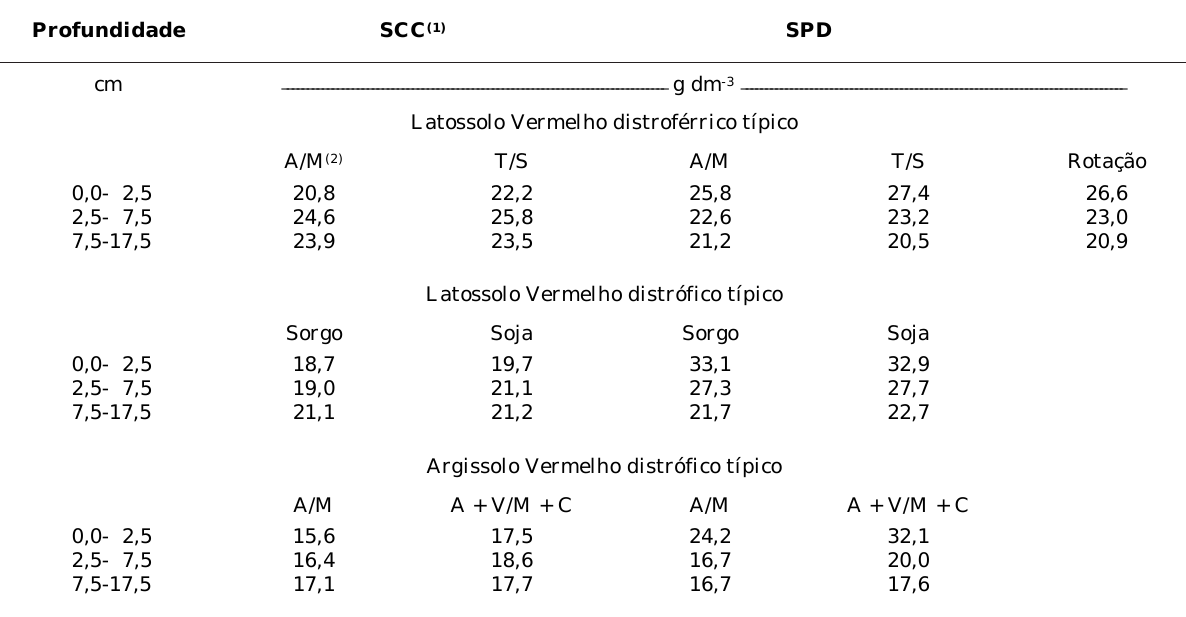
(1) SCC = sistema de cultivo convencional e SPD = sistema plantio direto. (2) A/M = aveia preta/milho; T/S = trigo/soja; Rotação = inverno (trigo, tremoço, colza e aveia preta + trevo) e verão (milho e soja); Sorgo e Soja = sorgo e soja antecedendo a coleta do solo; A + V/M + C = aveia preta + vica/milho +